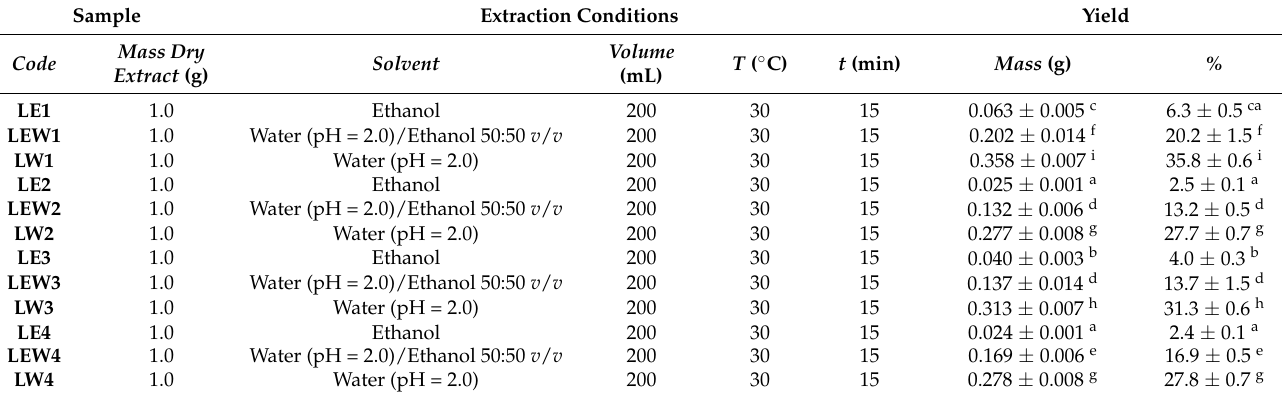
Table 1. Ultrasound-assisted extractions of wine lees from different